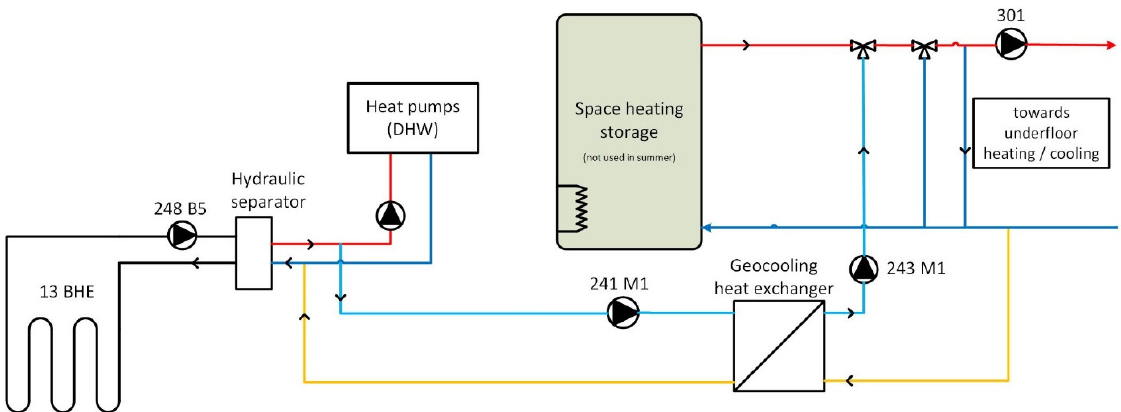
Figure 4. Scheme of the summer operation using geocooling (source: [22]).